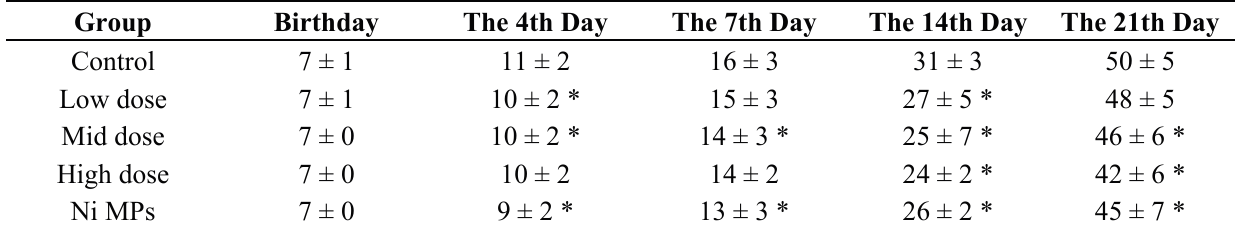
Table 4. Body weight changes of pup rats during the experiment